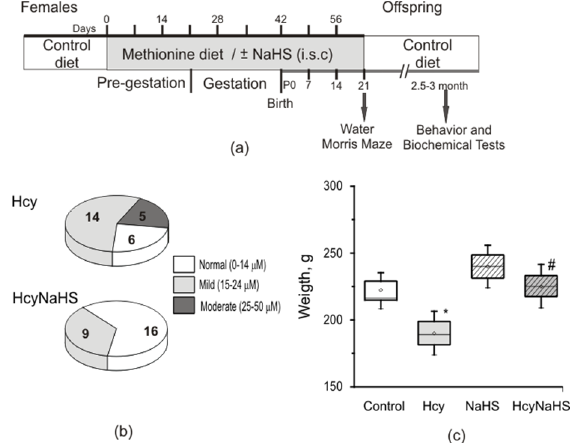
Figure 1. Experimental design and homocysteine level in rats with maternal hHcy. ( a ) Schematic representation of the experimental design. ( b ) Ratio of animals with normal (white sector, 0–14 μM), mild hHcy (grey sector, 15–24 μM), and moderate hHcy (dark grey sector, 25–50 μM) of Hcy and HcyNaHS groups (the number of rats is indicated at the sectors). ( c ) Average weight of rats from control (white box), NaHS (dashed box), Hcy (grey box), HcyNaHS (grey dashed box) groups. Boxes indicate SEM, horizontal lines—median, the small circle inside boxes—mean value, whiskers—5–95 percentile of data. * p < 0.05 compared to the control group, # p < 0.05 compared to the Hcy group.